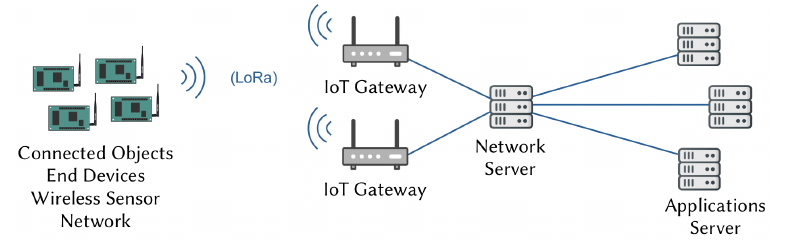
Figure 1. IoT network architecture.